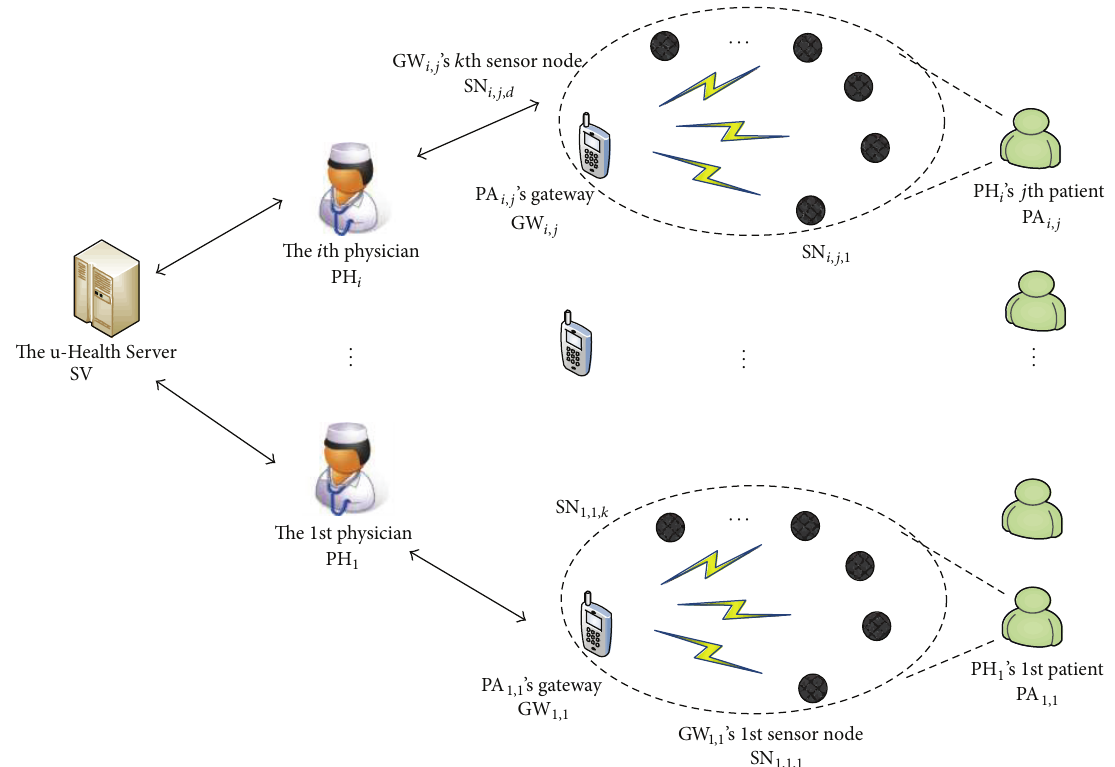
Figure 1: Basic hierarchical key agreement structure in